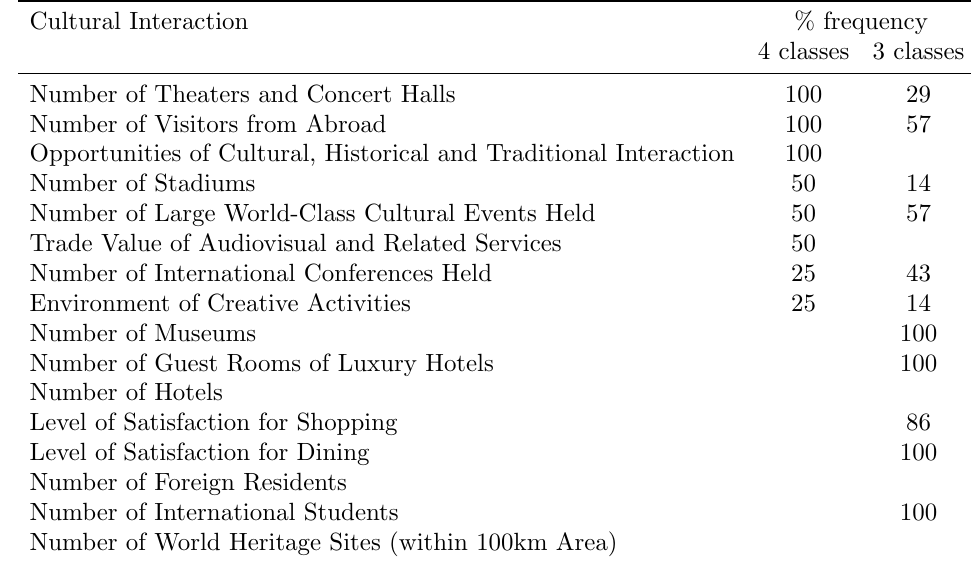
Table A.3: Frequency scores of the sub-sub factors of Research and Development Research and Development % frequency Number of Winners of Highly-Reputed Prizes Interaction Opportunities Between Researchers